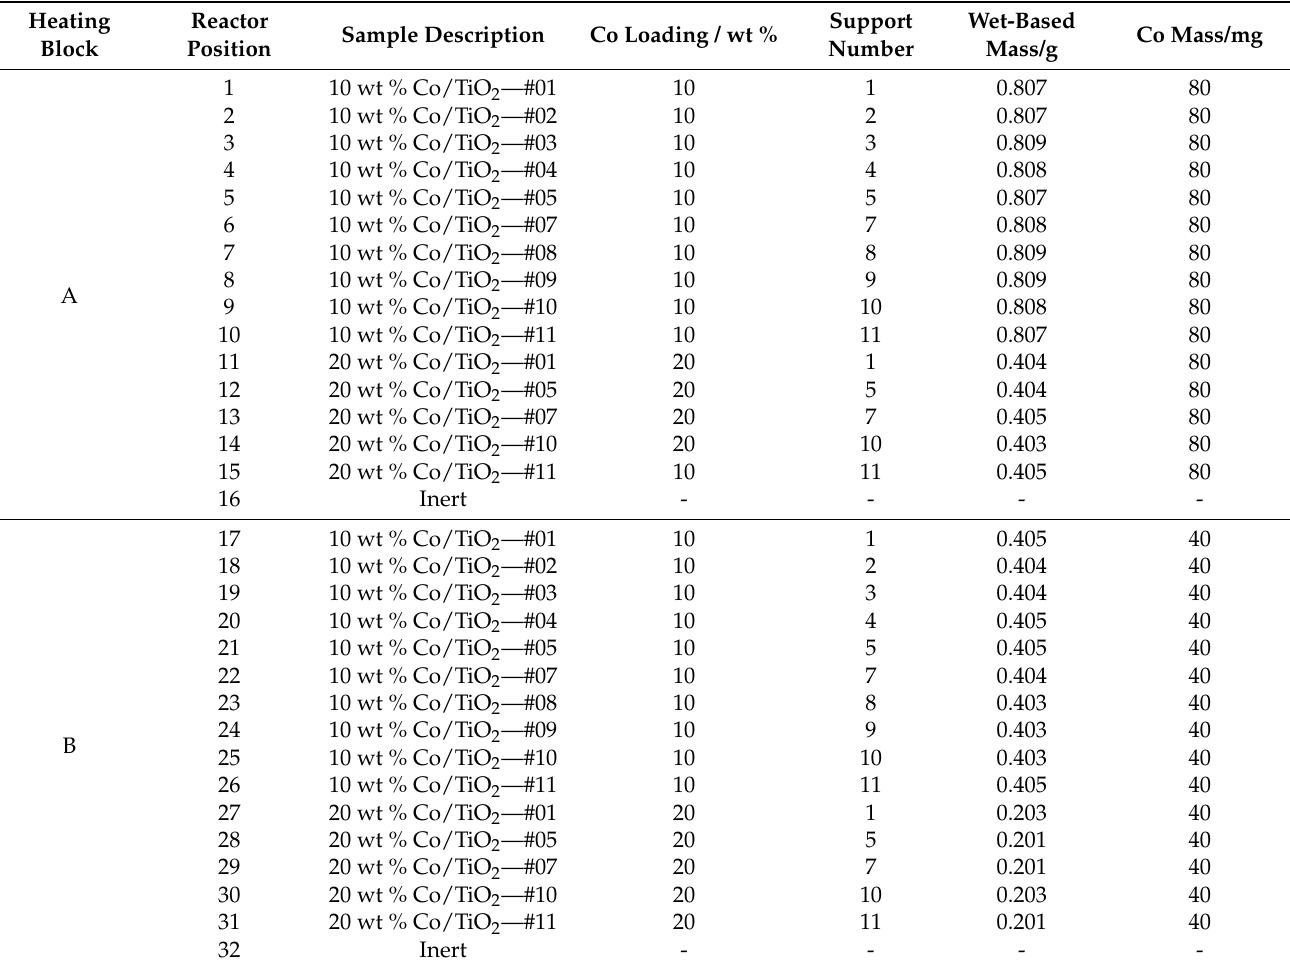
Table 3. Reactor loading design for parallel